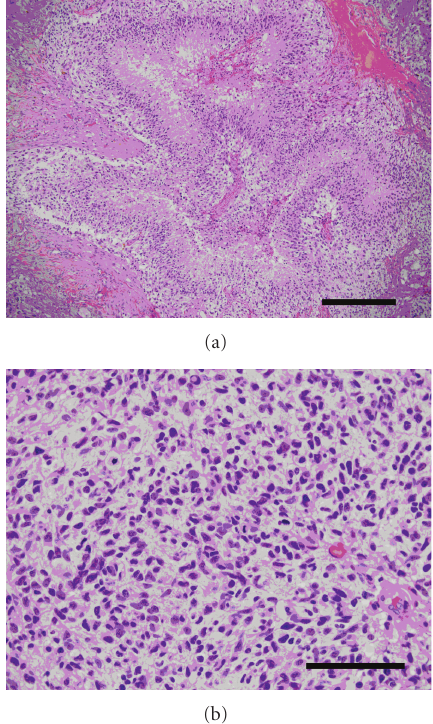
Figure 2: Histological slide from the right parietooccipital biopsy with hematoxylin and eosin staining. (a) Low-magnification micro- graph showing serpiginous areas of necrosis with pseudopalisad- ing and vascular proliferation (Scale bar = 0.3mm). (b) High- magnification micrograph showing hyperchromatic nuclei and frequent mitoses (Scale bar = 0.1 mm). These findings are consistent with a diagnosis of glioblastoma, WHO grade